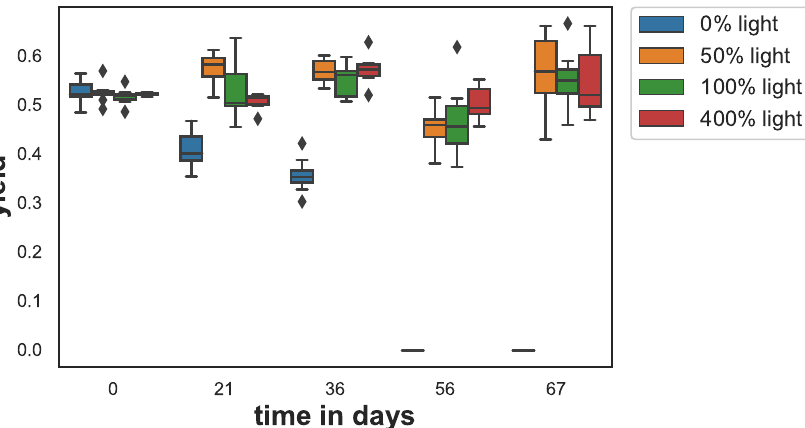
Figure 1. Trend of the fluorescent optimum quantum yield as a proxy for photosynthetic activity. The box shows the quartiles of the dataset while the whiskers show the rest of the distribution, except for outliers that are plotted as